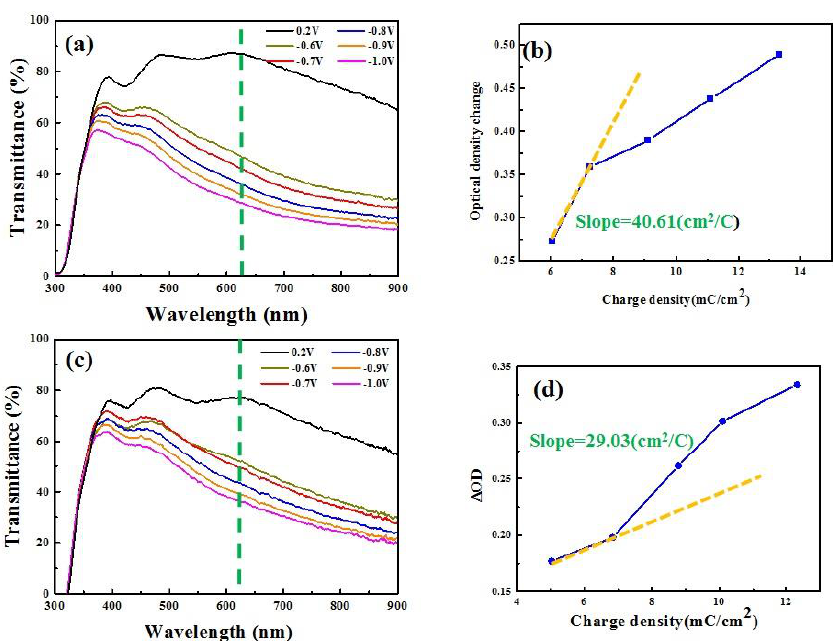
Figure 10. ( a , c ) The transmittance spectra of IZTO-based and ITO-based ECDs in the range from 300 to 900 nm using varying voltage from 0.2 V to − 1.0 V. ( b , d ) ΔOD versus charge density at 633 nm of IZTO − based and ITO − based ECDs.